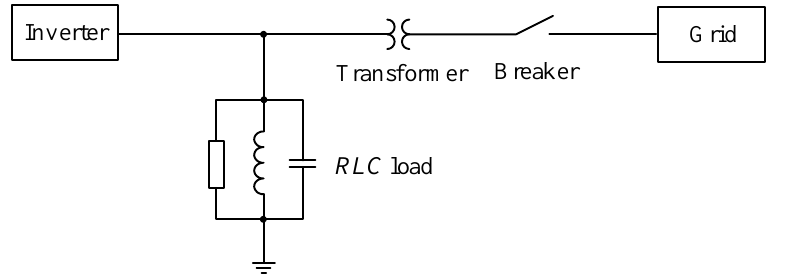
Figure 10. The connection mode of the inverter system.